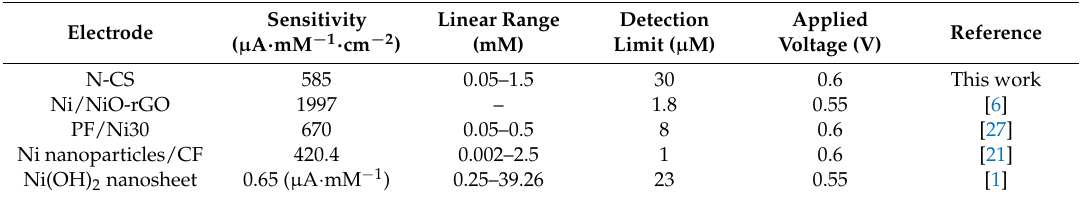
Table 1. Comparison of glucose performances of the N-CS/SPCE with the recently reported nickel-based non-enzymatic glucose sensors.